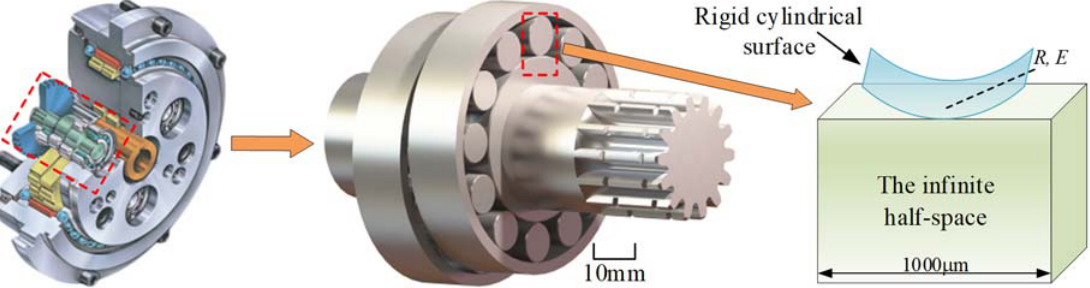
Figure 12. The contact model of the crankshaft and the cylindrical roller bearing.